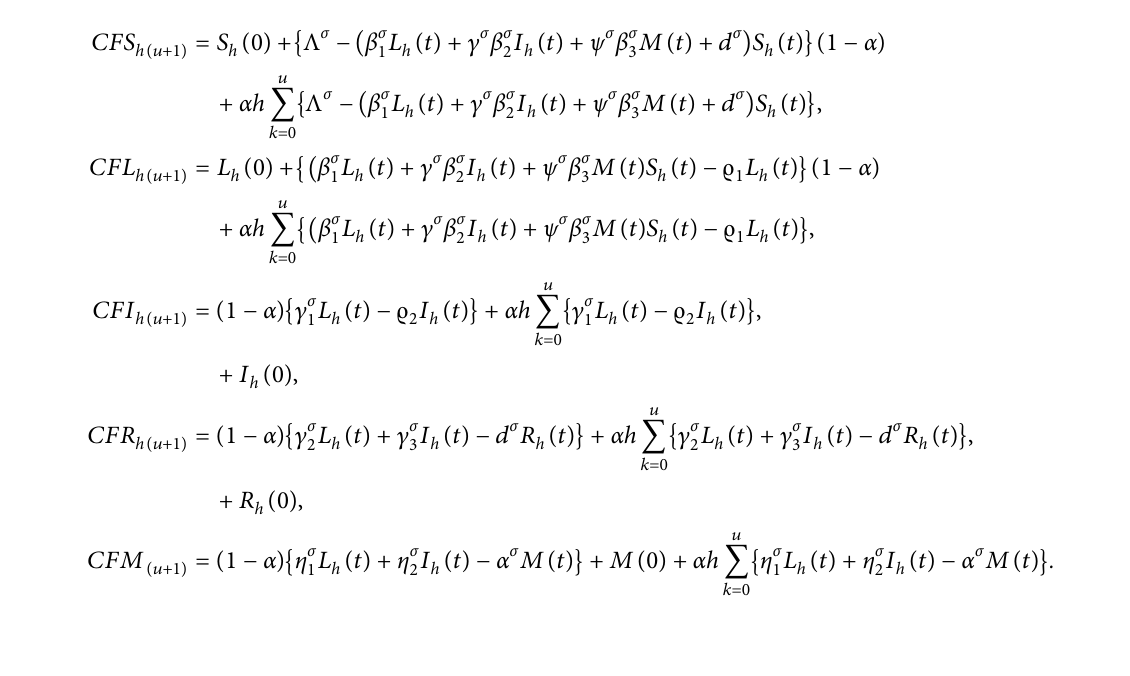
� 0 . 011, β � 0 . 005, ψ � 0 . 016, β 1 2